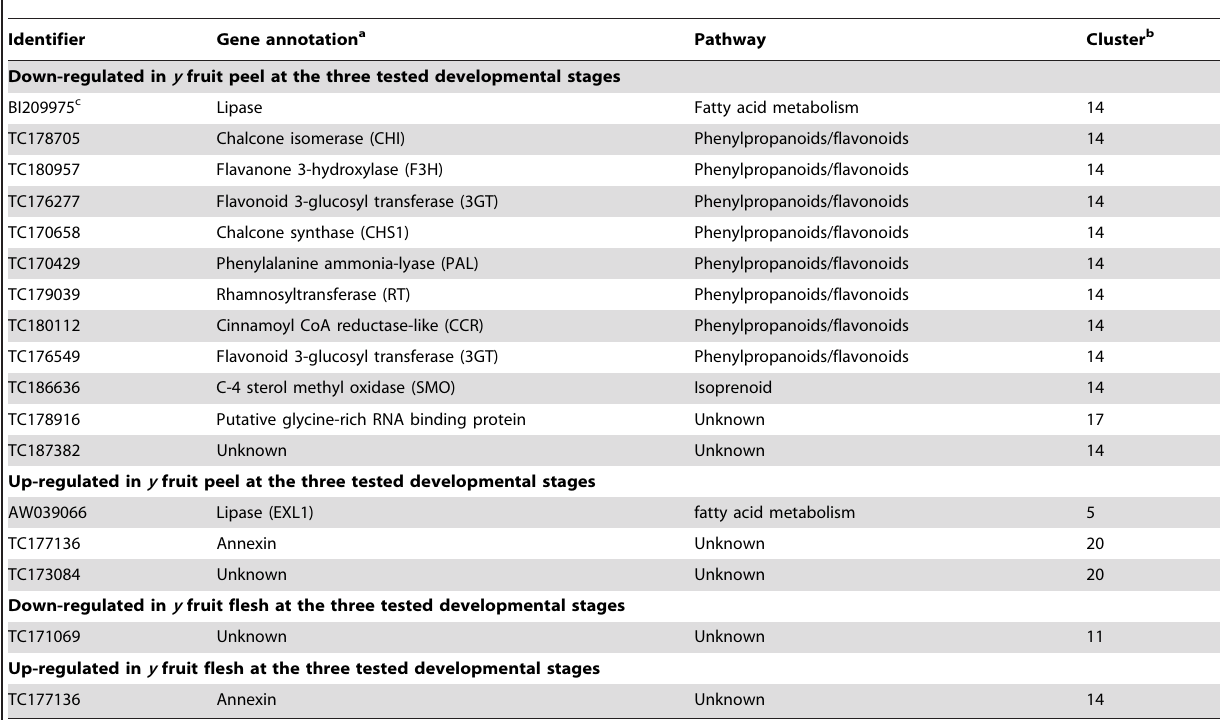
Table 1. Genes down/up-regulated in peel or flesh tissues of the y mutant at the three tested stages of tomato fruit development (breaker, orange,